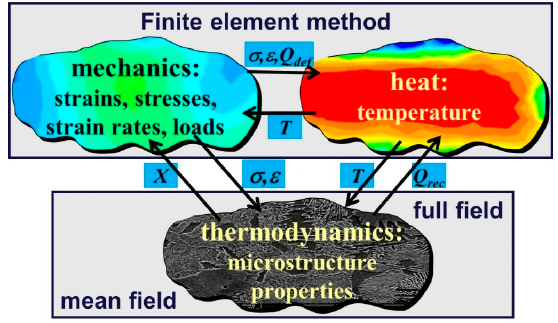
Figure 11. The idea of the multiphysics modelling of metal forming, σ —stress, ε —strain, T — temperature, Q def —heat generated due to plastic work, Q rec —heat generated due to transformations, X —volume fractions of